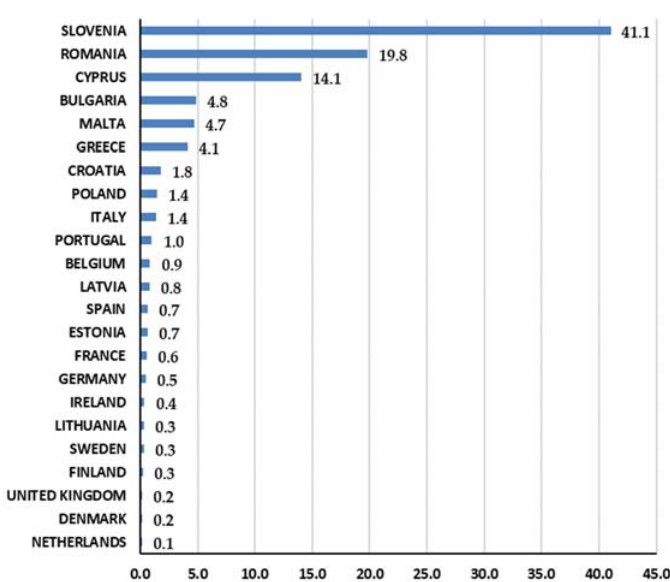
Figure 3. Percentage distribution of the FEMP by employment generated for the period 2014–2020. Source: Own elaboration from data published by the European Commission. https://ec.europa. eu/oceans-and-fisheries/funding/european-maritime-and-fisheries-fund-emff_es (accessed on 11 January 2022).